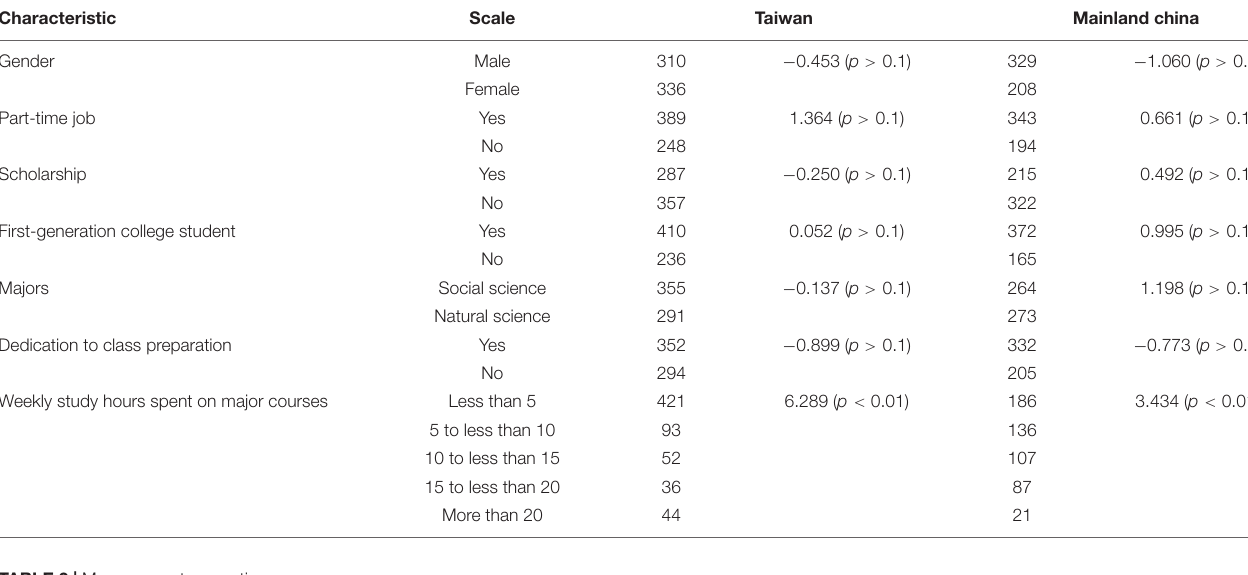
TABLE 1 | Descriptive statistics by Taiwanese and mainland China samples.